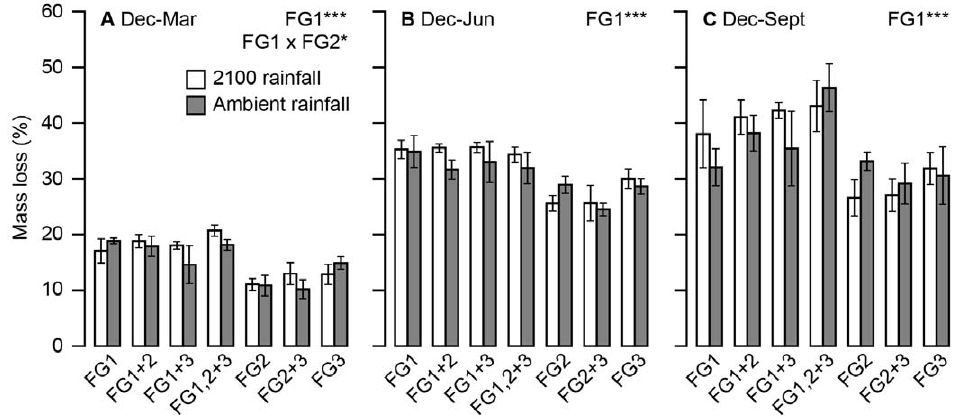
Figure 2. Effect of precipitation change and functional identity on decomposition of Holcus mollis at different time points. Decomposition of H. mollis litter in 2009 for all fourteen treatments. a) Dec–Mar F 1,49 =32.87, p , 0.001, b) Dec–Jun F 1,49 =40.23, p , 0.001, c) Dec–Sept F 1,49 =20.31, p , 0.001. Error bars represent 6 1 SEM.